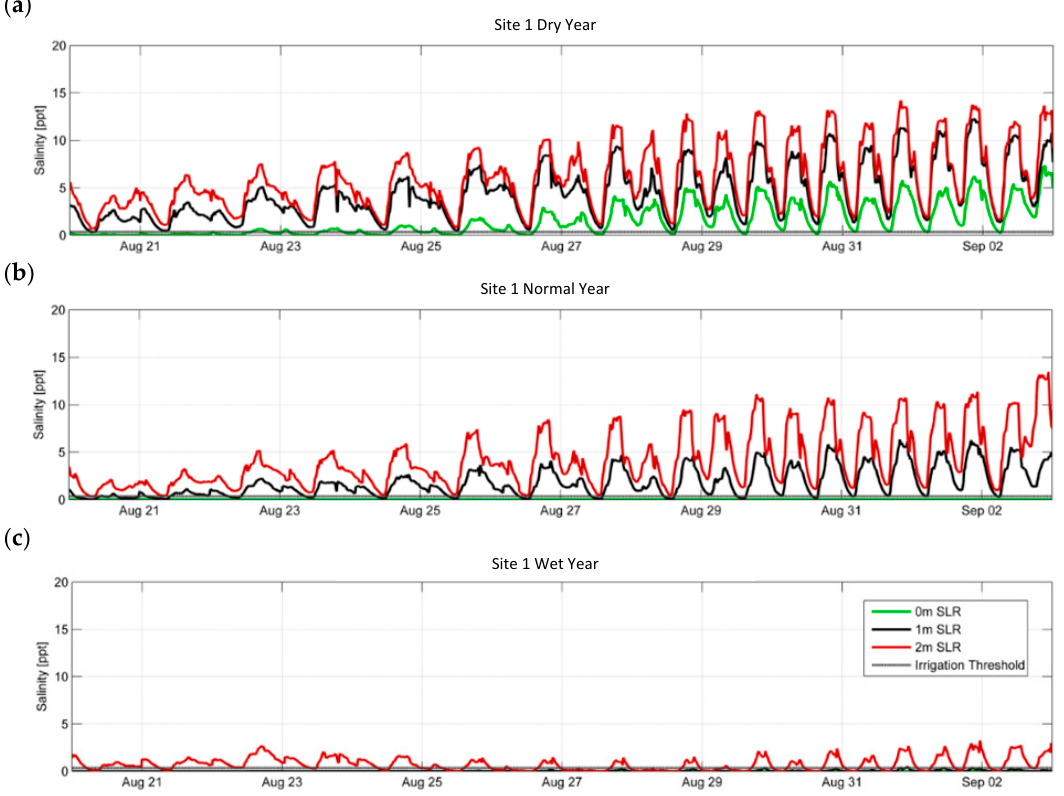
Figure 14. Surface salinity at site 1 in August with 0–2 m SLR: ( a ) dry year; ( b ) normal year; ( c ) wet year.